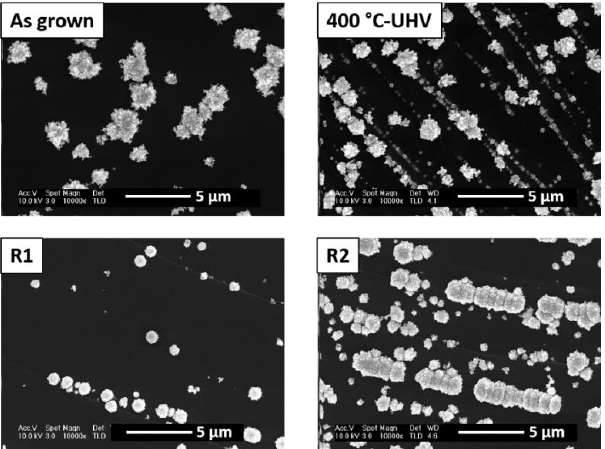
Figure 5. 10,000× magnification SEM images for as grown and thermal treated ZnO/HOPG samples.